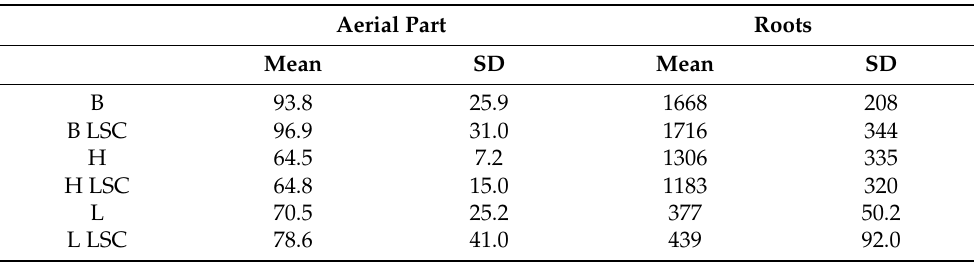
Table 4. Concentration values (mg kg − 1 ) of As absorbed by the plants. Values are reported as mean ± standard deviation (SD).